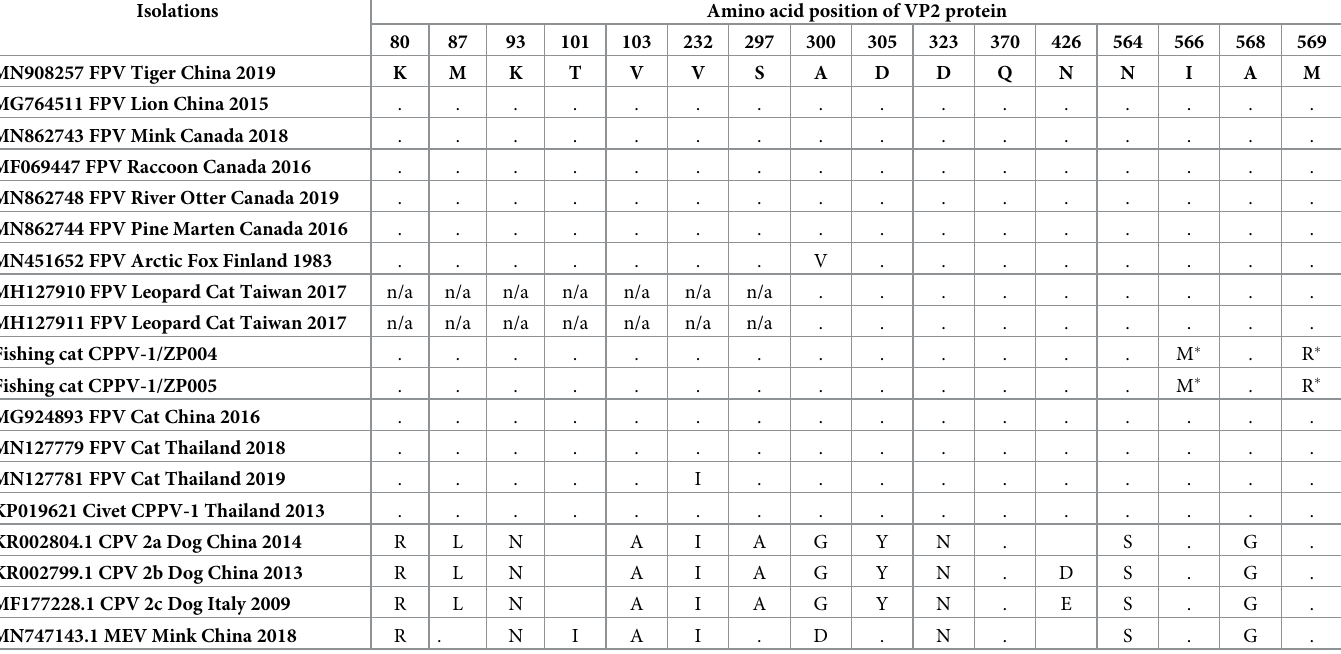
Table 1. Alignment of capsid amino acid sequence of CPPV-1 isolated from fishing cats with previously described CPPV-1 variants retrieved from the NCBI data- base. The accession numbers, the CPPV-1 variant, infected host, country and year of sample collection are